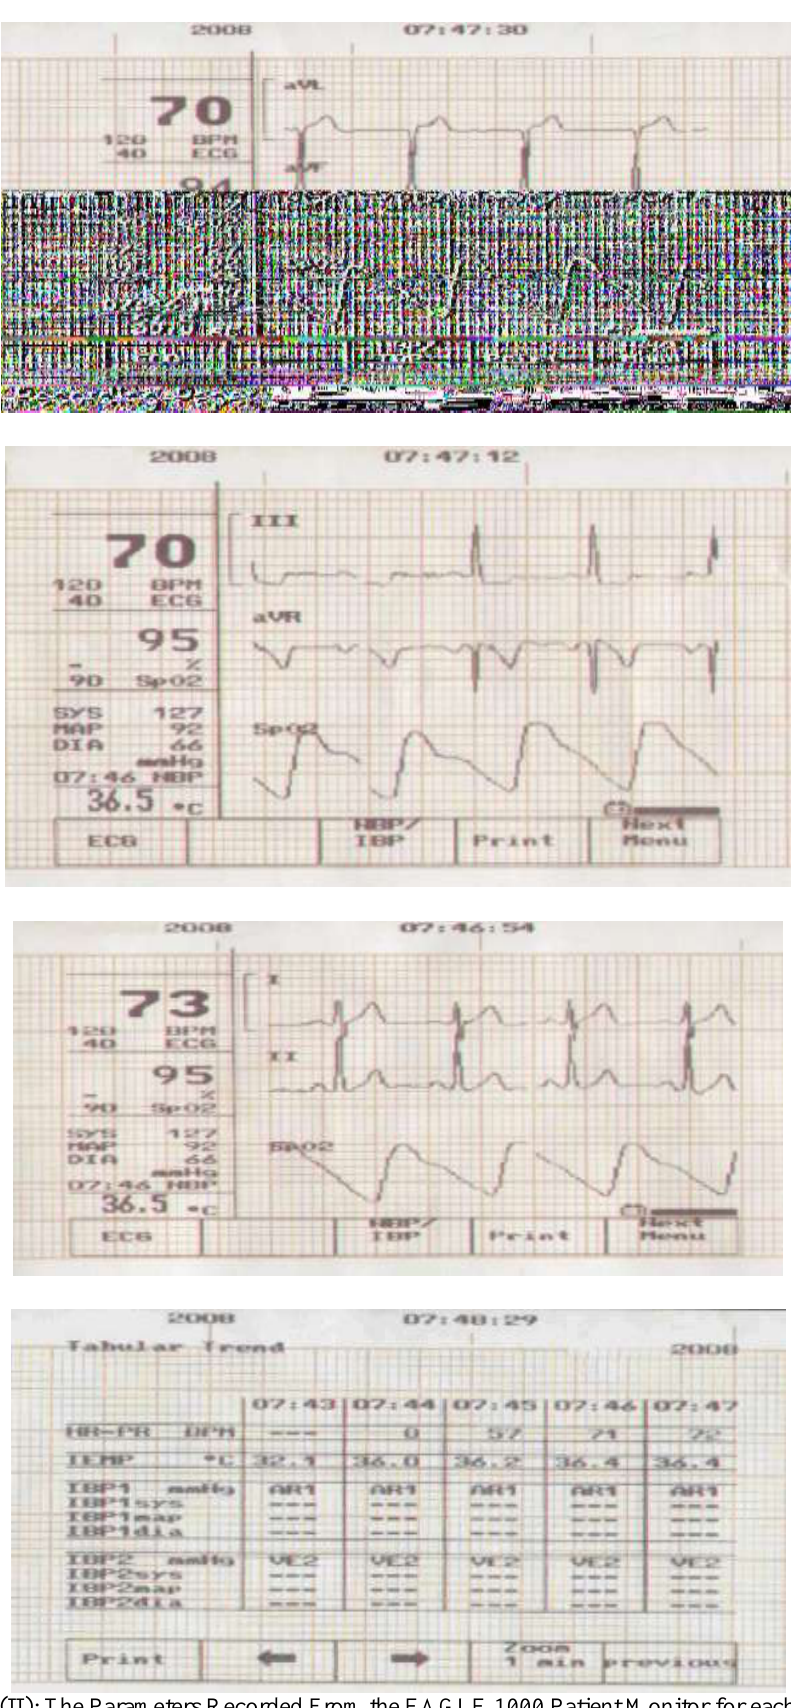
Figure (II): The Parameters Recorded From the EAGLE 1000 Patient Monitor for each